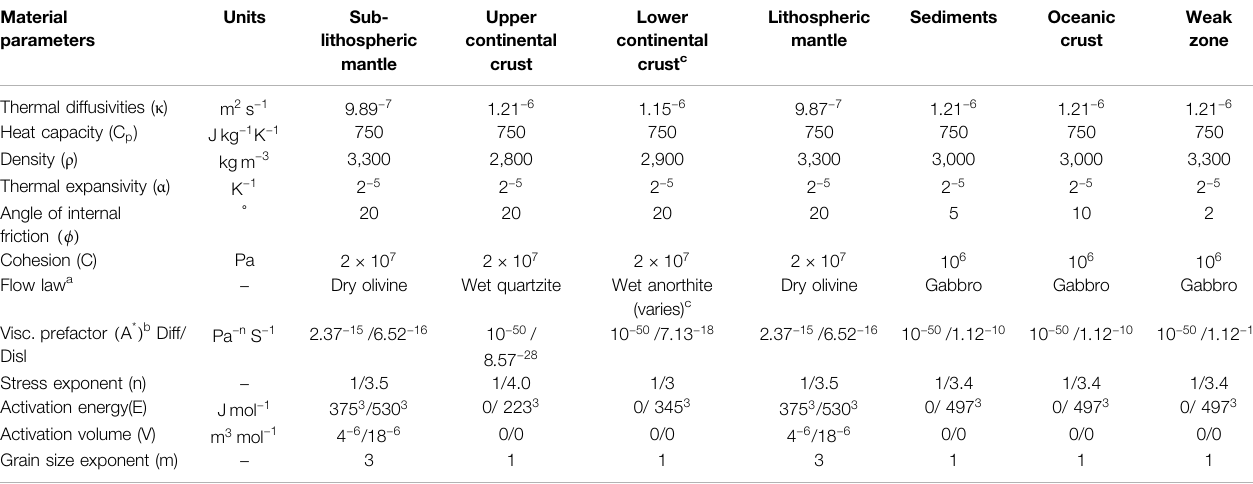
TABLE 1 | Parameter list of the numerical experiments. Material